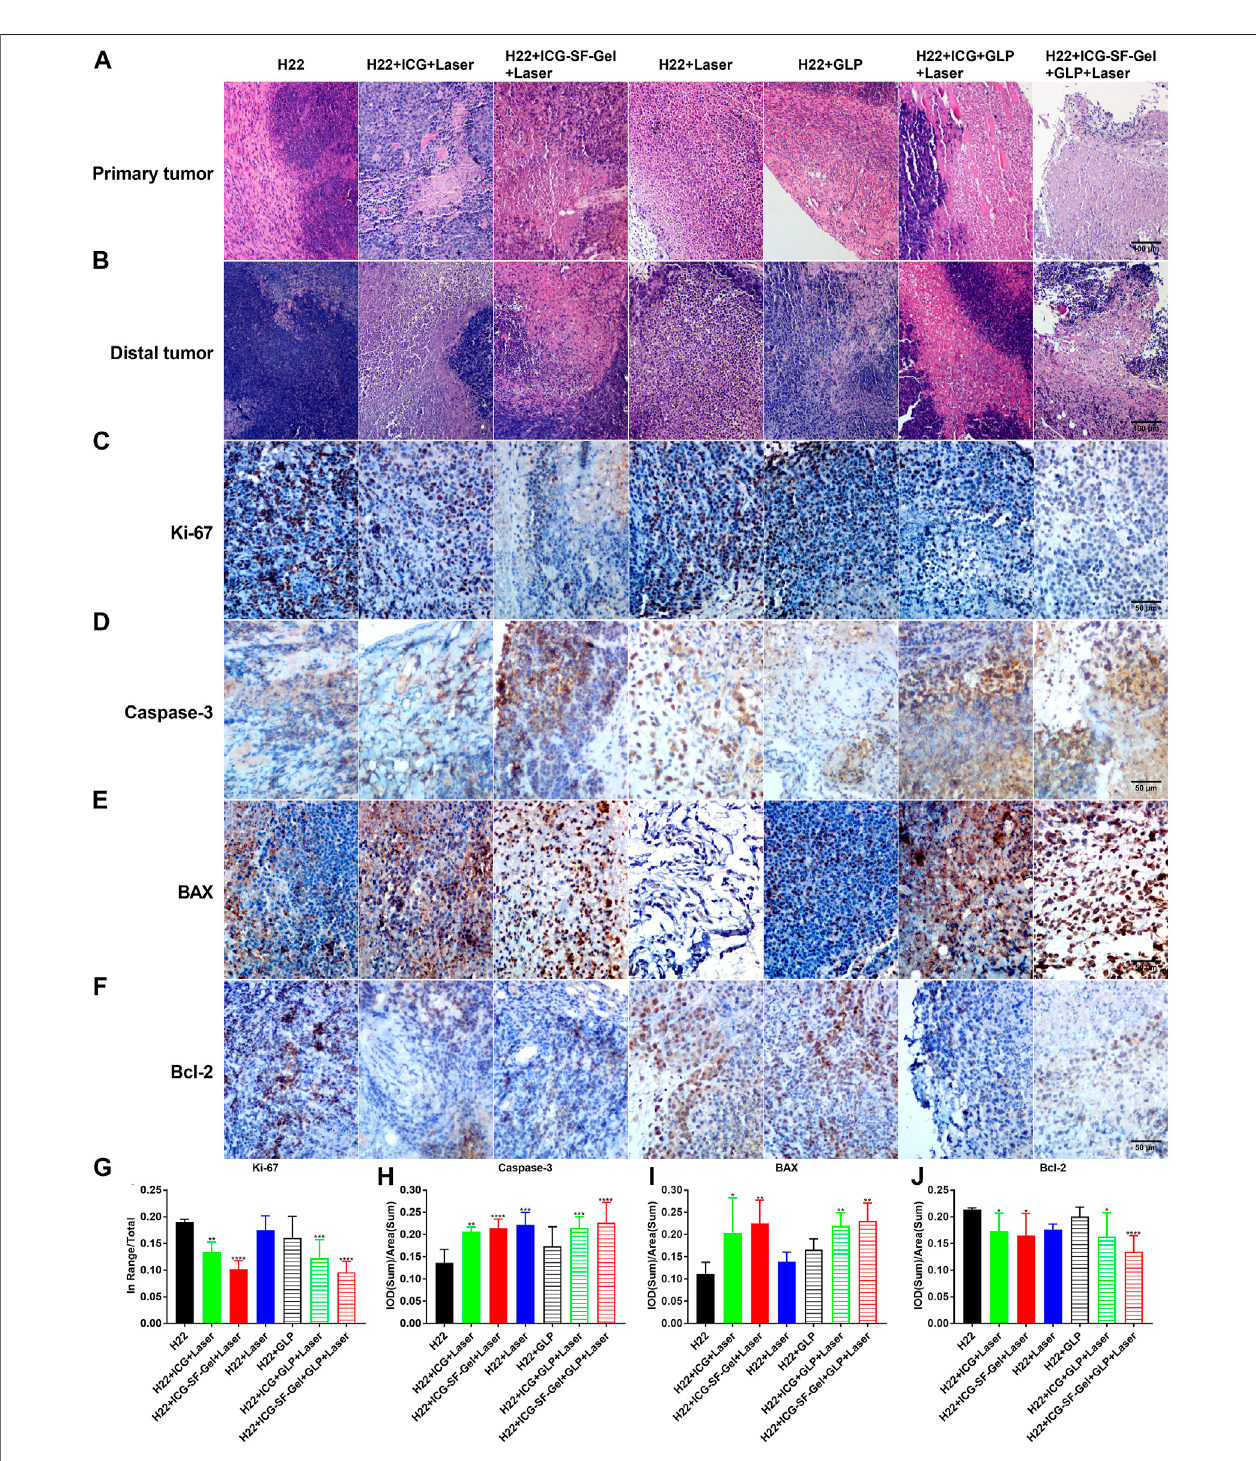
FIGURE 5 | Morphological changes, pathological changes, and cell proliferation of tumor tissues after different treatments. (A,B) The Haematoxylin-eosin staining ofprimarytumors (A) anddistaltumors (B) collectedfromdifferenttreatedgroupsofmice7 daysafter thedistaltumor inoculation (Thesamerowshared thesamescale bar: 100 μ m); (C – F) Immunohistochemical staining of Ki-67 (C) , Caspase-3 (D) , BAX (E) and Bcl-2 (F) of distal tumors collected from different treated groups of mice 7 days after thedistal tumor inoculation (The samerowshared thesame scale bar:50 µm)and quantitativeanalysisofKi-67 (G) , Caspase-3 (H) ,BAX (I) and Bcl-2 (J) ( n (cid:2) 4 mice per group, data are presented as the mean ± SD. Statistical signi fi cance was expressed by * p < 0.05, ** p < 0.01, *** p < 0.001 and **** p < 0.0001, comparing other groups with the H22 group).